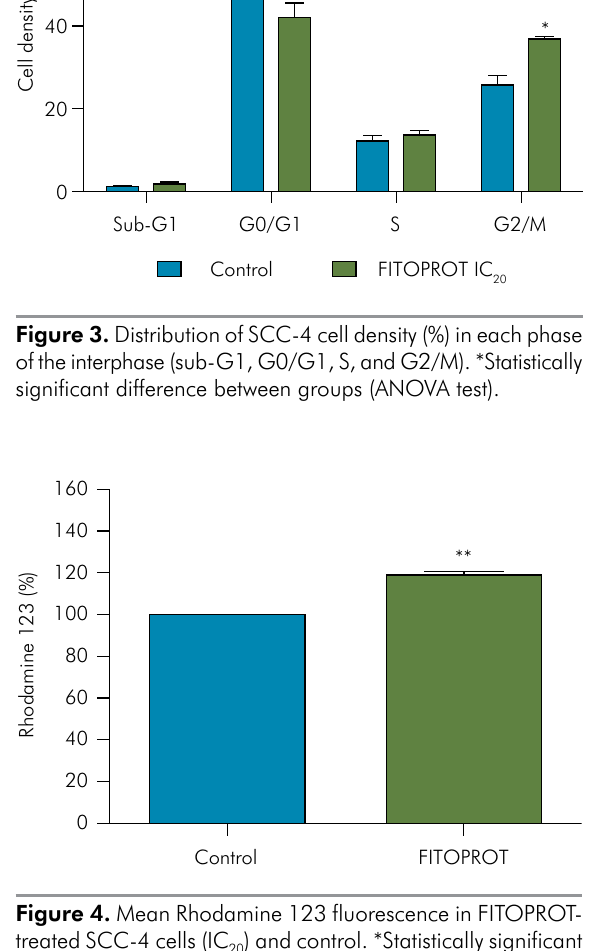
Figure 2. Reduction in viability (%) of FITOPROT-treated SCC- 4 cells (IC = 0.0625% and IC = 0.1%). 20 50